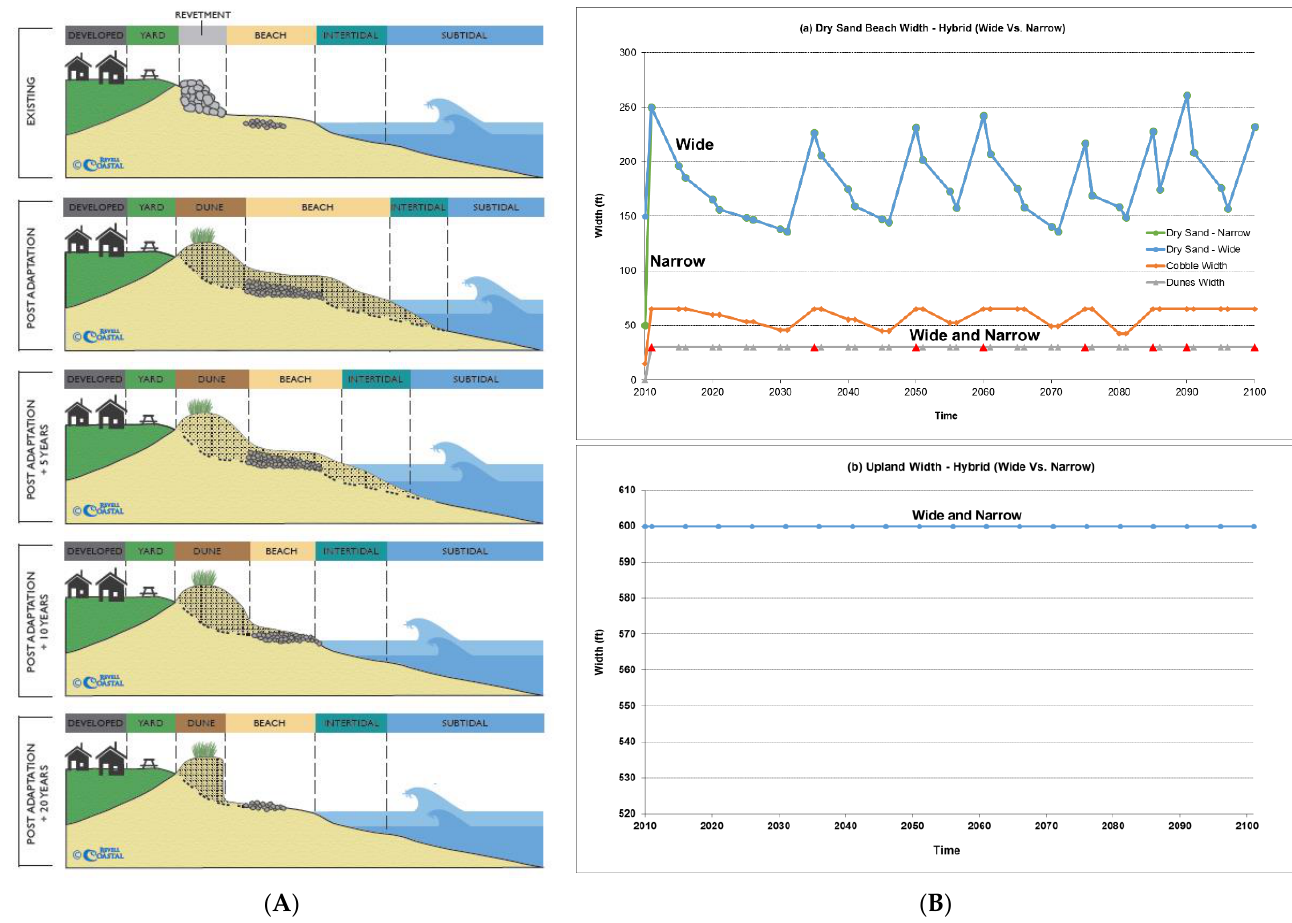
Figure 10. ( A ) Evolution of the living cobble and dune shoreline strategy over time. Example does not illustrate the shortening time between nourishment cycles as sea level rises. ( B ) Dry sand beach width over time with armoring (wide vs. narrow beach) (Ba top plot); upland width over time with armoring (wide vs. narrow beach) (Bb bottom plot).